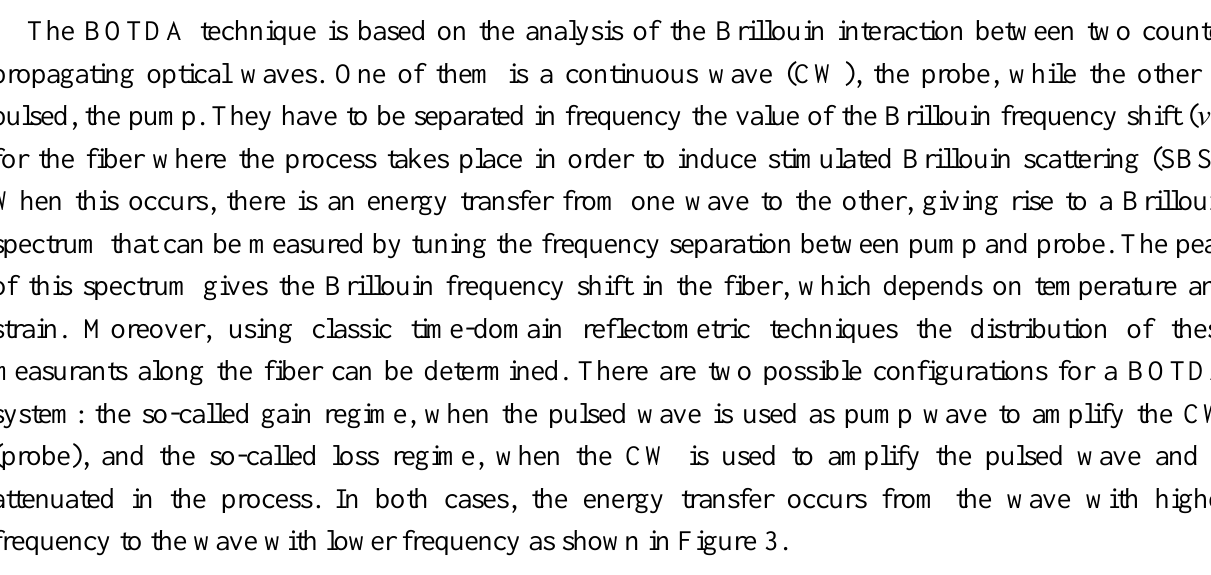
Figure 3. BOTDA signals relationship in gain and loss regime. The dashed line represents the energy